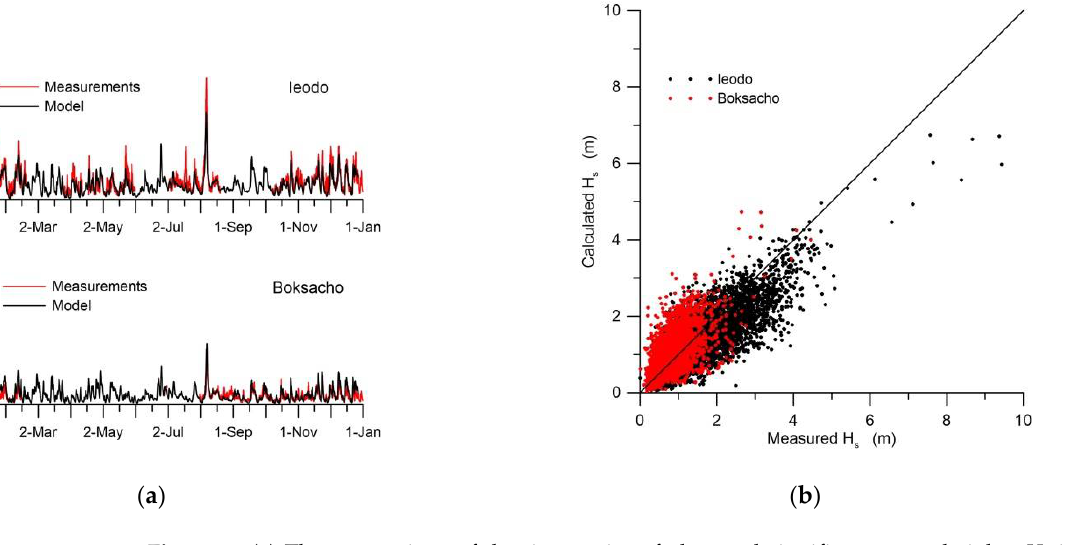
Figure 7. ( a ) The comparison of the time series of observed significant wave heights H s in 2011 with computed values in two locations of KHOA buoys [37] as shown in Figure 3; ( b ) measured vs. calculated H s for two locations of KHOA buoys in 2011.